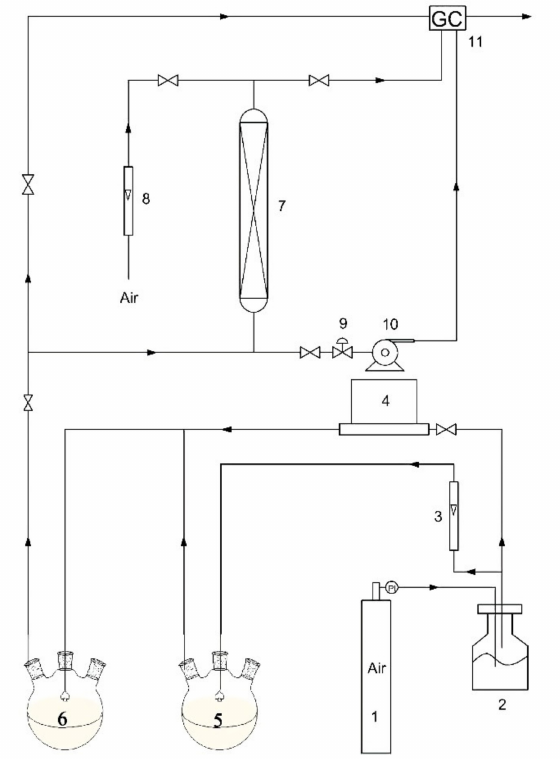
Figure 1. Experimental device diagram (1: Air cylinder; 2: Silica gel dryer; 3: Rotameter; 4: Mass flowmeter; 5: VOC generator; 6: Buffer bottle; 7: Adsorption column; 8: Rotameter; 9: Vacuum degree regulating valve; 10: Vacuum pump; 11: Gas